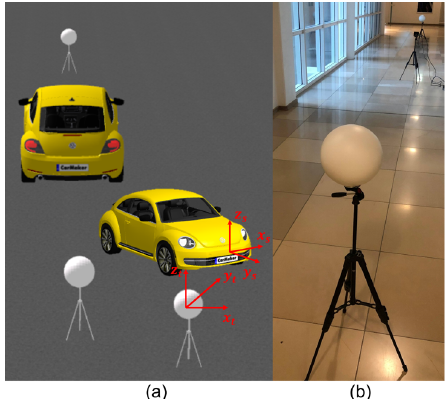
Figure 19. Measurement setup for the inside test. ( a ) Static simulation scene for the inside test. ( b ) Real static scene for the inside test. The sphere targets were placed at a distance of 6.7m from the DUT in the simulation and real measurements. The reference distance d ref is calculated from the sensor’s origin to the target’s center. The coordinates of simulated and real objects and sensors are the same.